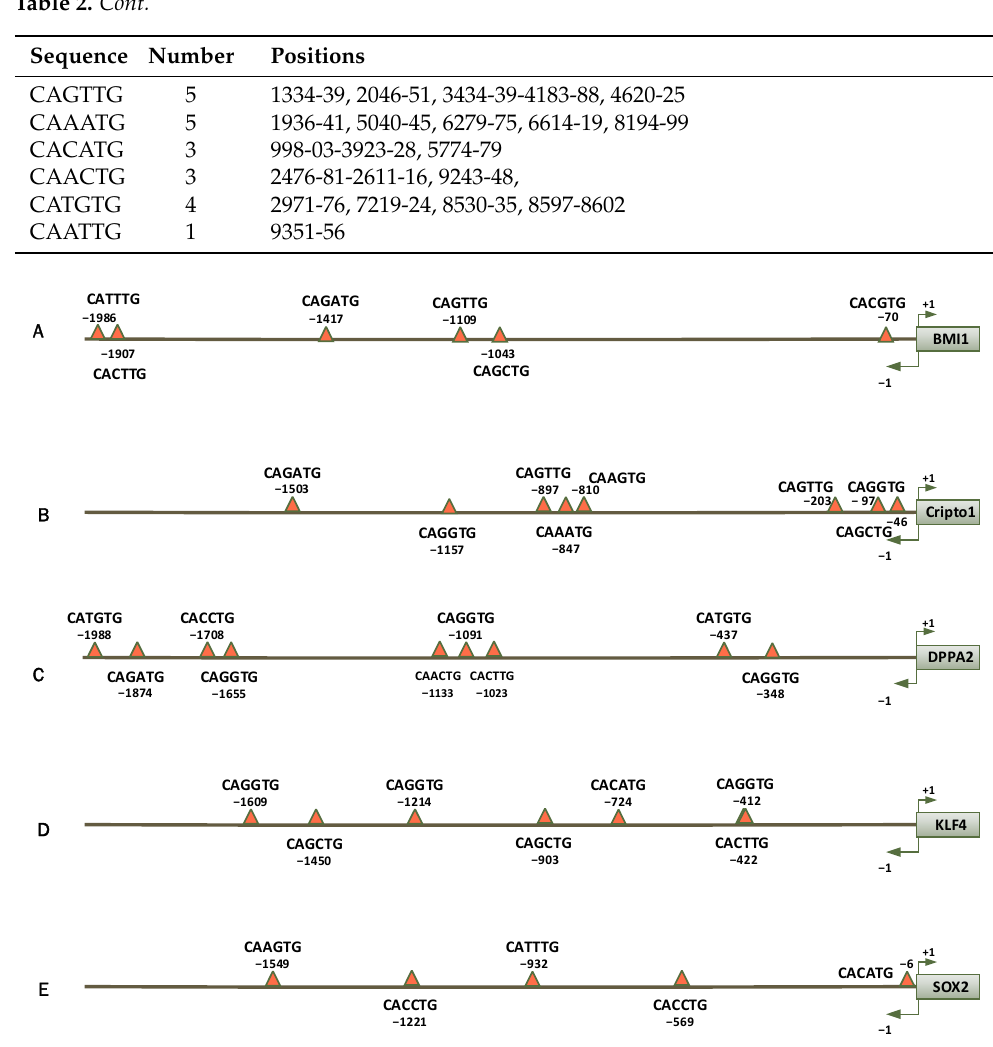
Figure 1. Schematic view of the positions and sequences of seven E-box hexanucleotide consensus sequence CANNTG within 2 Kb upstream of the genes transcription start site. ( A ) BMI1 promoter, Table 2. The number and positions of E-box hexanucleotide consensus sequence (CANNTG) in BMI1 transcription unit. The asterisks indicate exonic E-boxes. Table 3. The number and positions of E-box hexanucleotide consensus sequence (CANNTG) in Cripto1 transcription unit. The asterisks indicate exonic